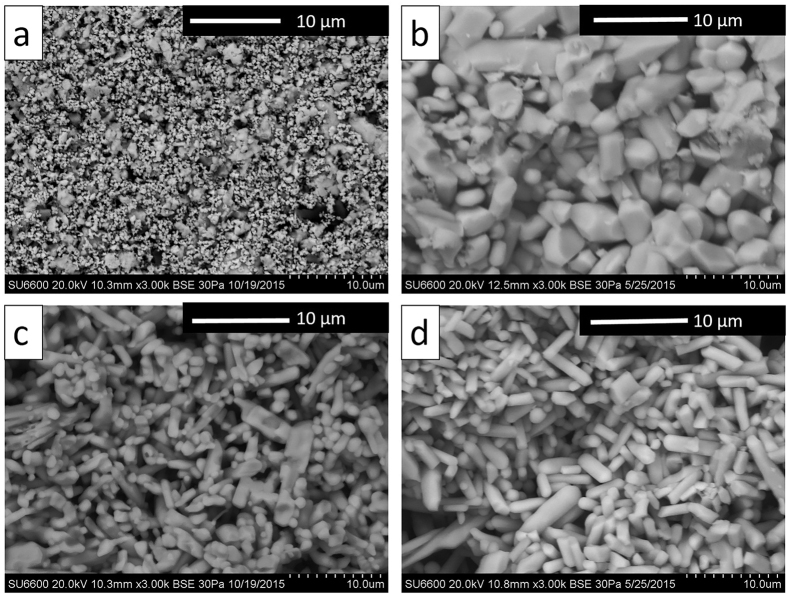
SEM-Backscattered Electron micrograph of the sintered pallets at magnification of 300X, (a) Ba1.33Cs0Ga2.32Ti5.68O16; (b) Ba1.04Cs0.24Ga2.32Ti5.68O16; (c) Ba0.667Cs0.667Ga2Ti6O16. (d) Cs1.33Ga1.33Ti6.67O16.